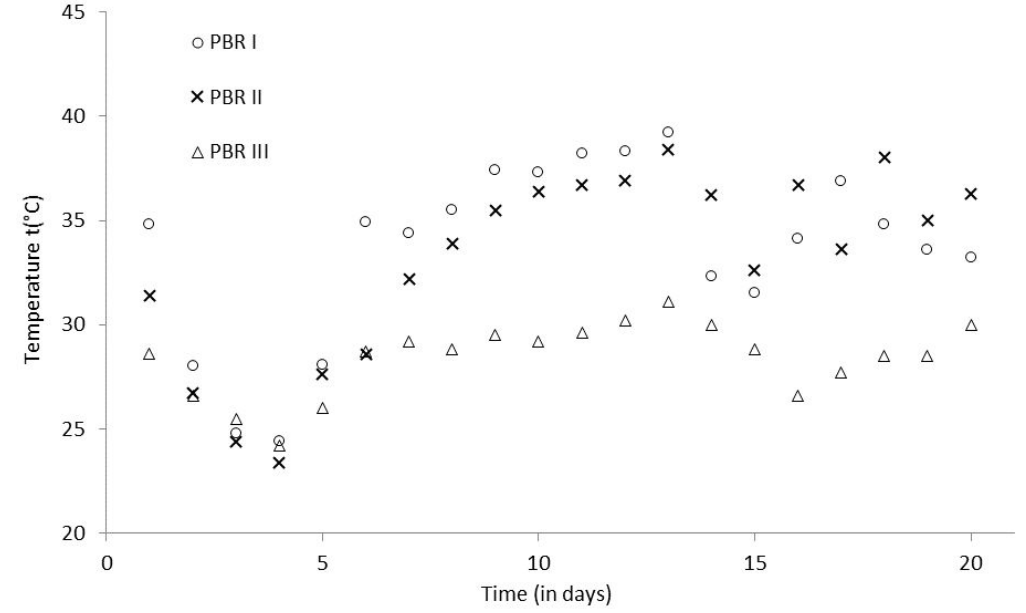
Figure 5. Temperature distribution over time, depending on the type of lighting system. Source: own